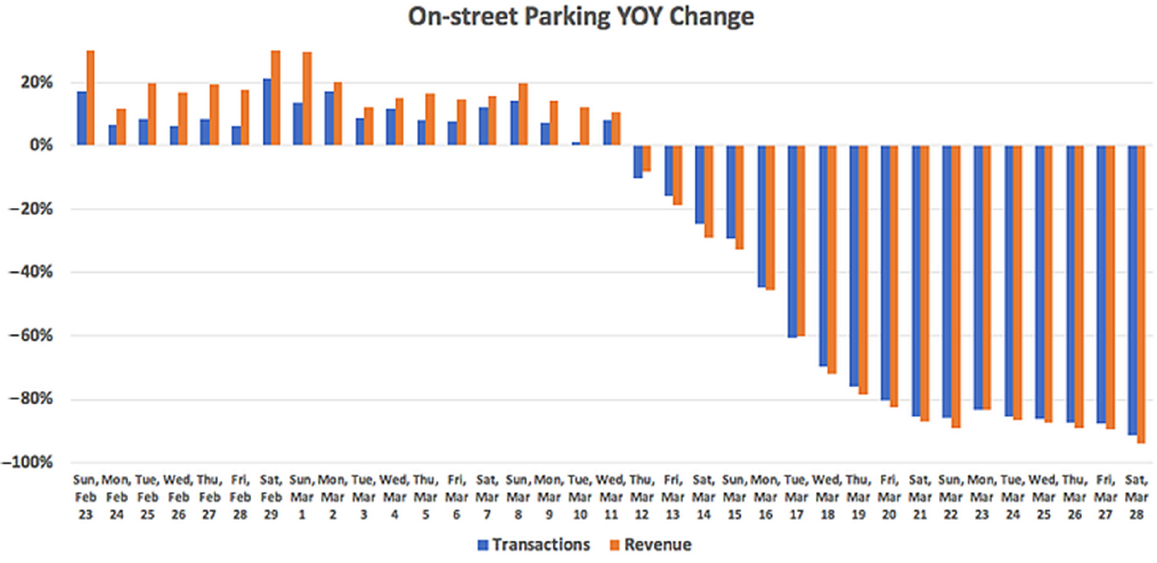
Figure 1. On-street parking year-over-year (YOY) change (from a random sample of 511 zones/blocks across the US).